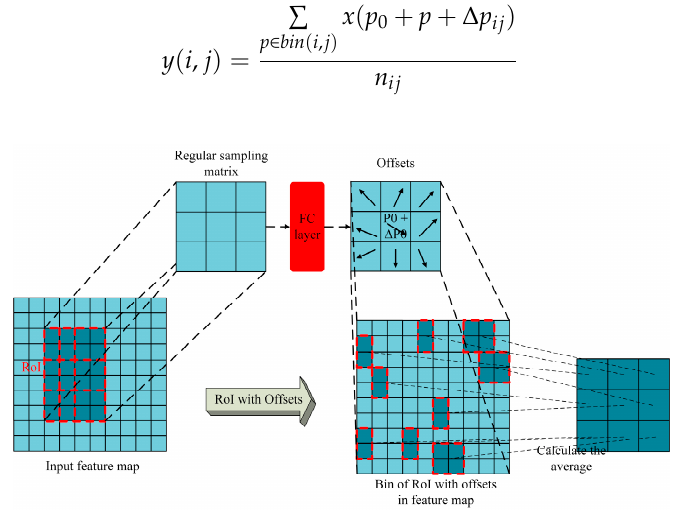
Figure 8. Illustration of 3 × 3 deformable RoI pooling.